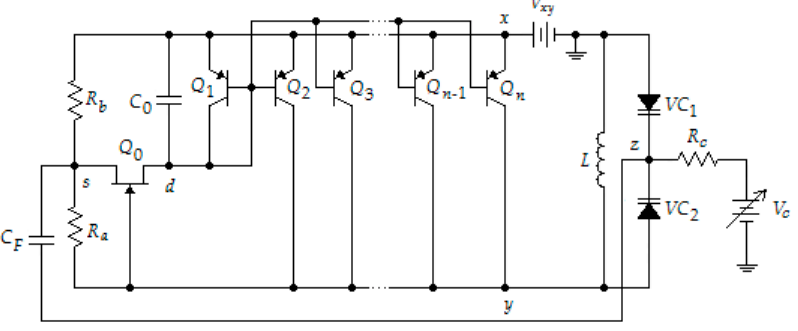
Figure 11. LC voltage-controlled oscillator with NDR.